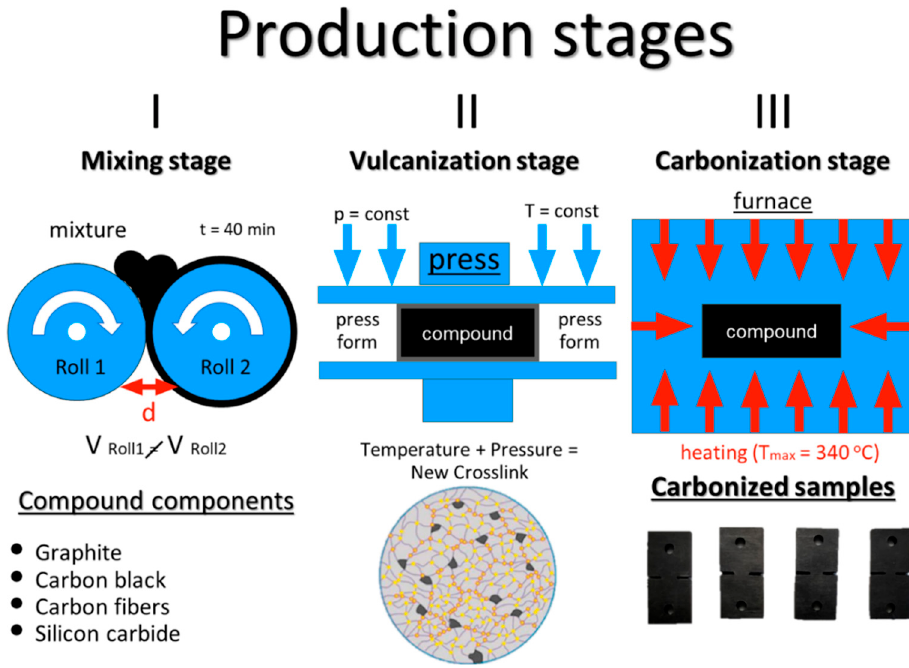
Figure 9. The workflow of preparation composite materials based on the carbonized polymer matrix.